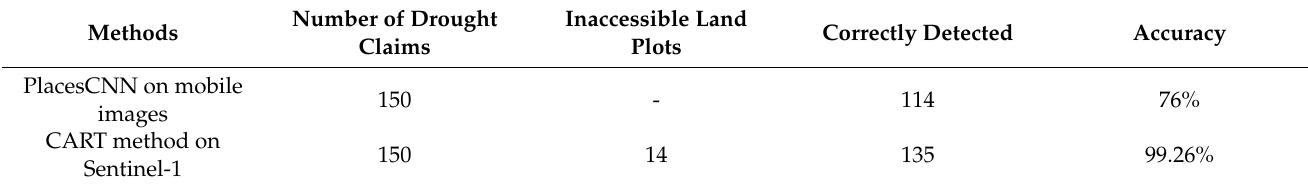
Table 8. Accuracy assessment using verified mobile images for drought detection with PlacesCNN on mobile images and the CART method on Sentinel-1 SAR GRD images for cloud-affected land plots in Sentinel-2A